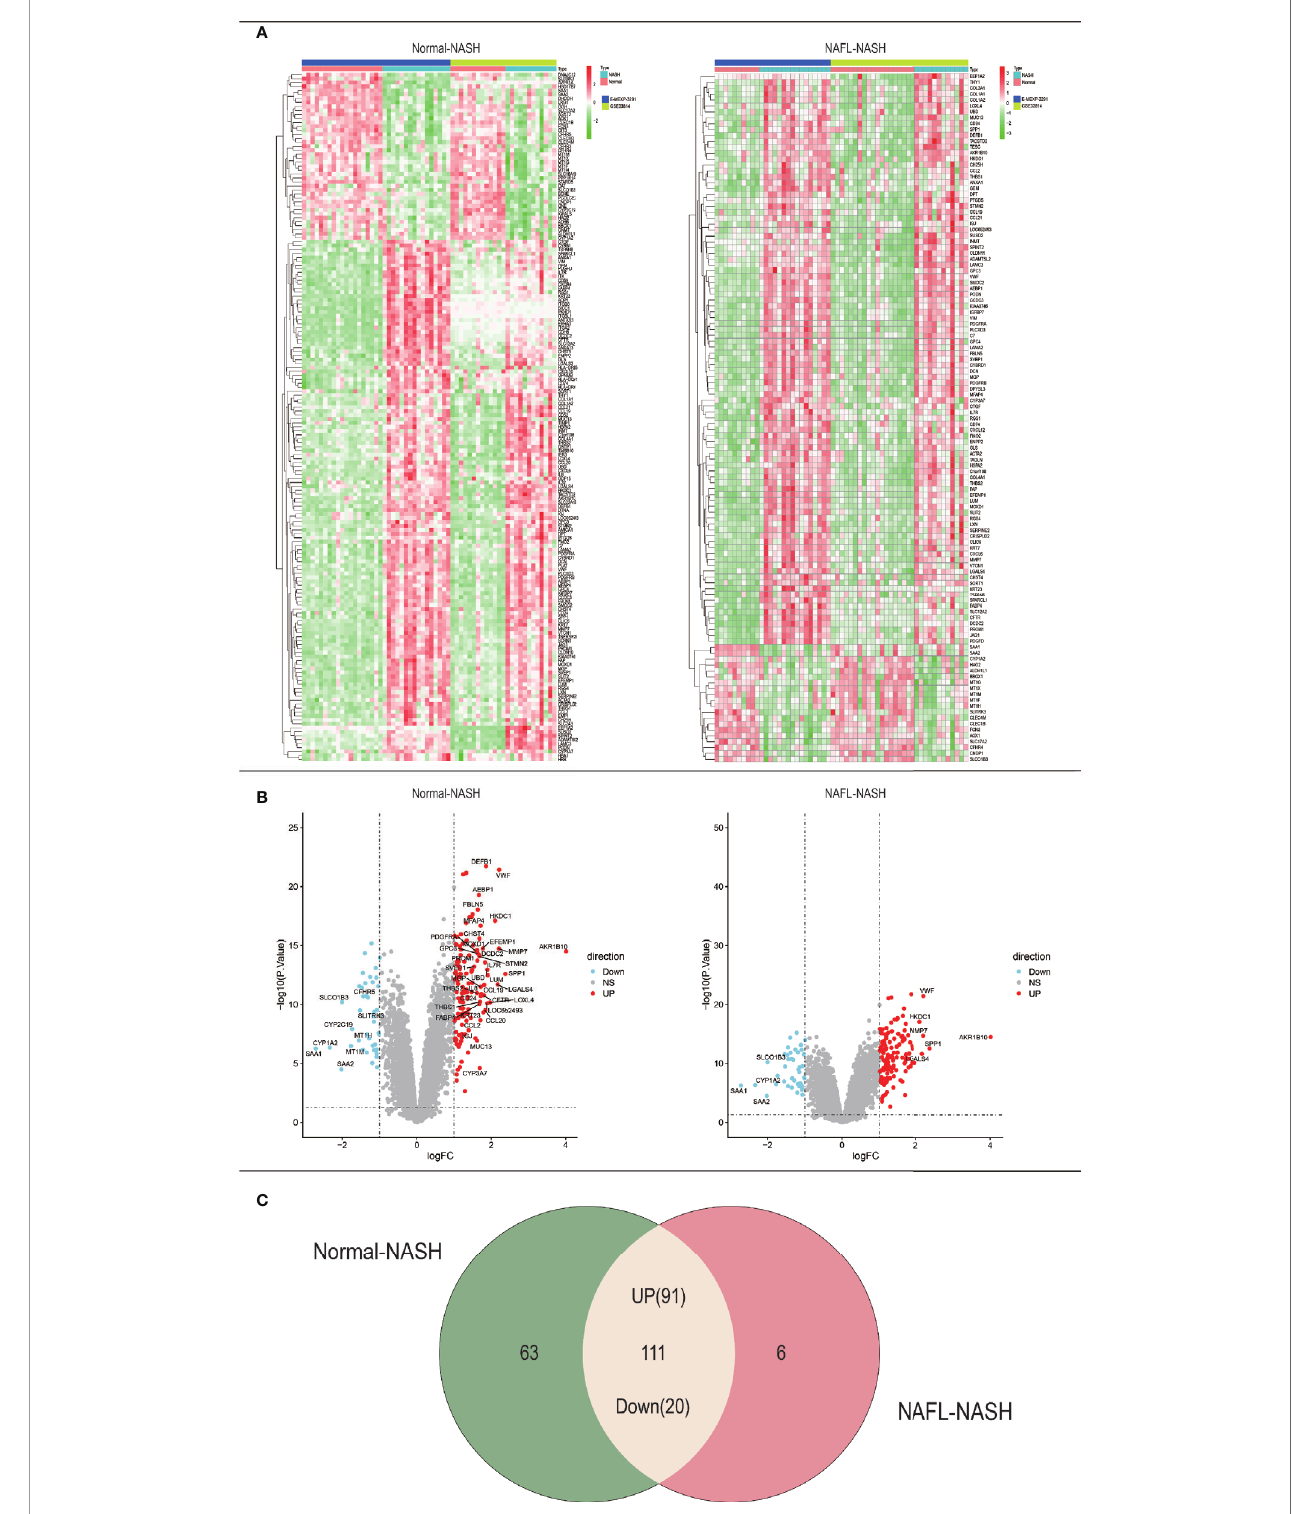
FIGURE 2 | Acquisition of differentially expressed genes (DEGs). (A) Heatmap of Normal-NASH group and NAFL-NASH group; (B) Volcano map of Normal-NASH group and NAFL-NASH group; (C) Venn diagram between Normal-NASH group and NAFL-NASH